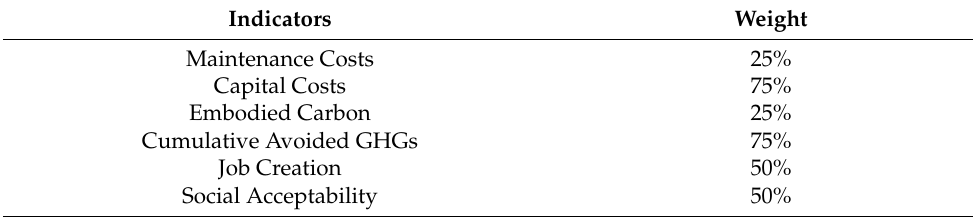
Table 7. The indicator